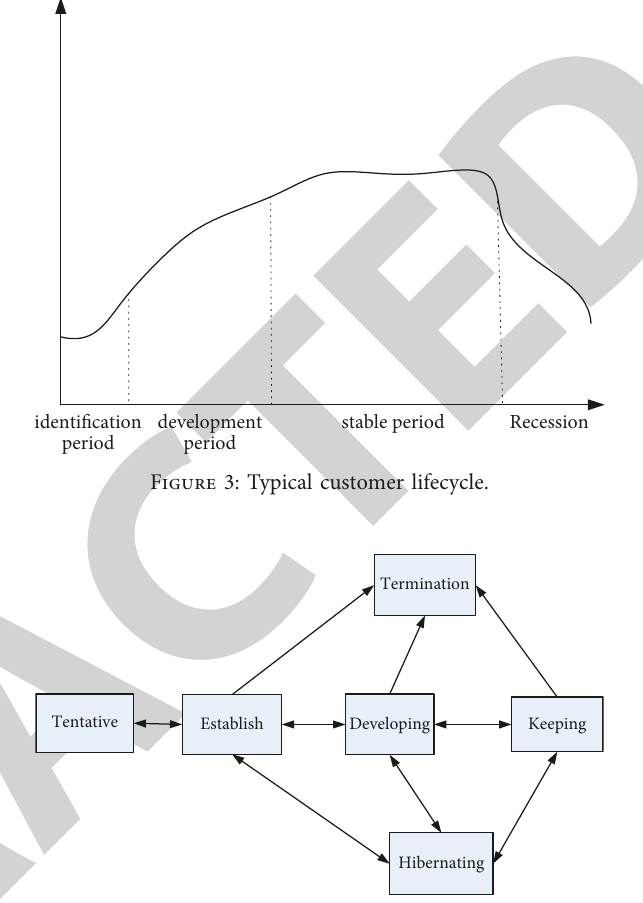
Figure 4: State model of customer relationship development